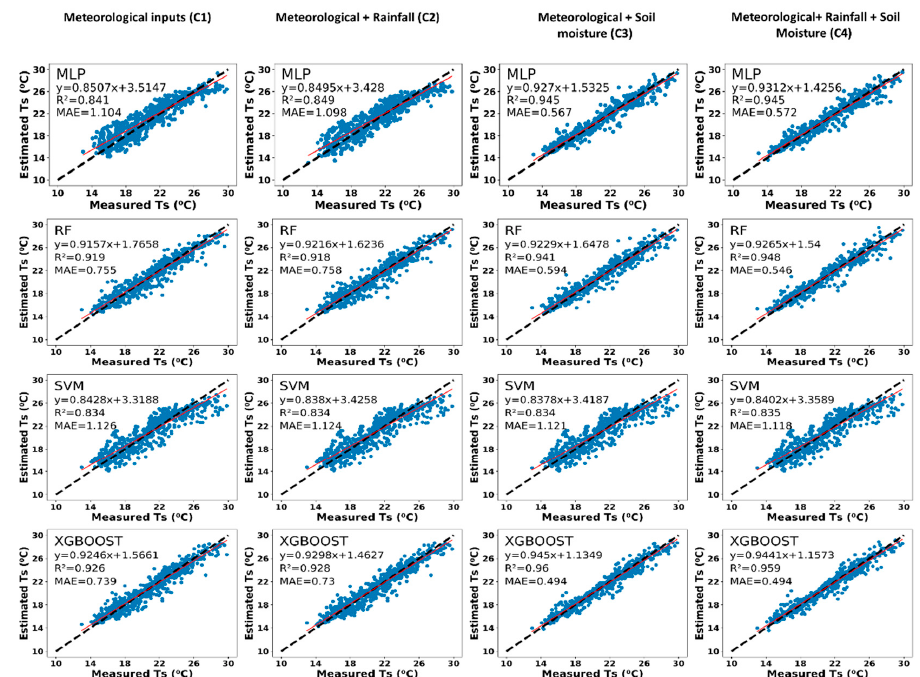
Figure 10. Scatter plots between estimated and measured half-hourly soil temperature (Ts) showing R 2 and MAE of 16 different model combinations for agro-forested hillslope (black dashed line represents 45 degree line and red solid line represents regression line).